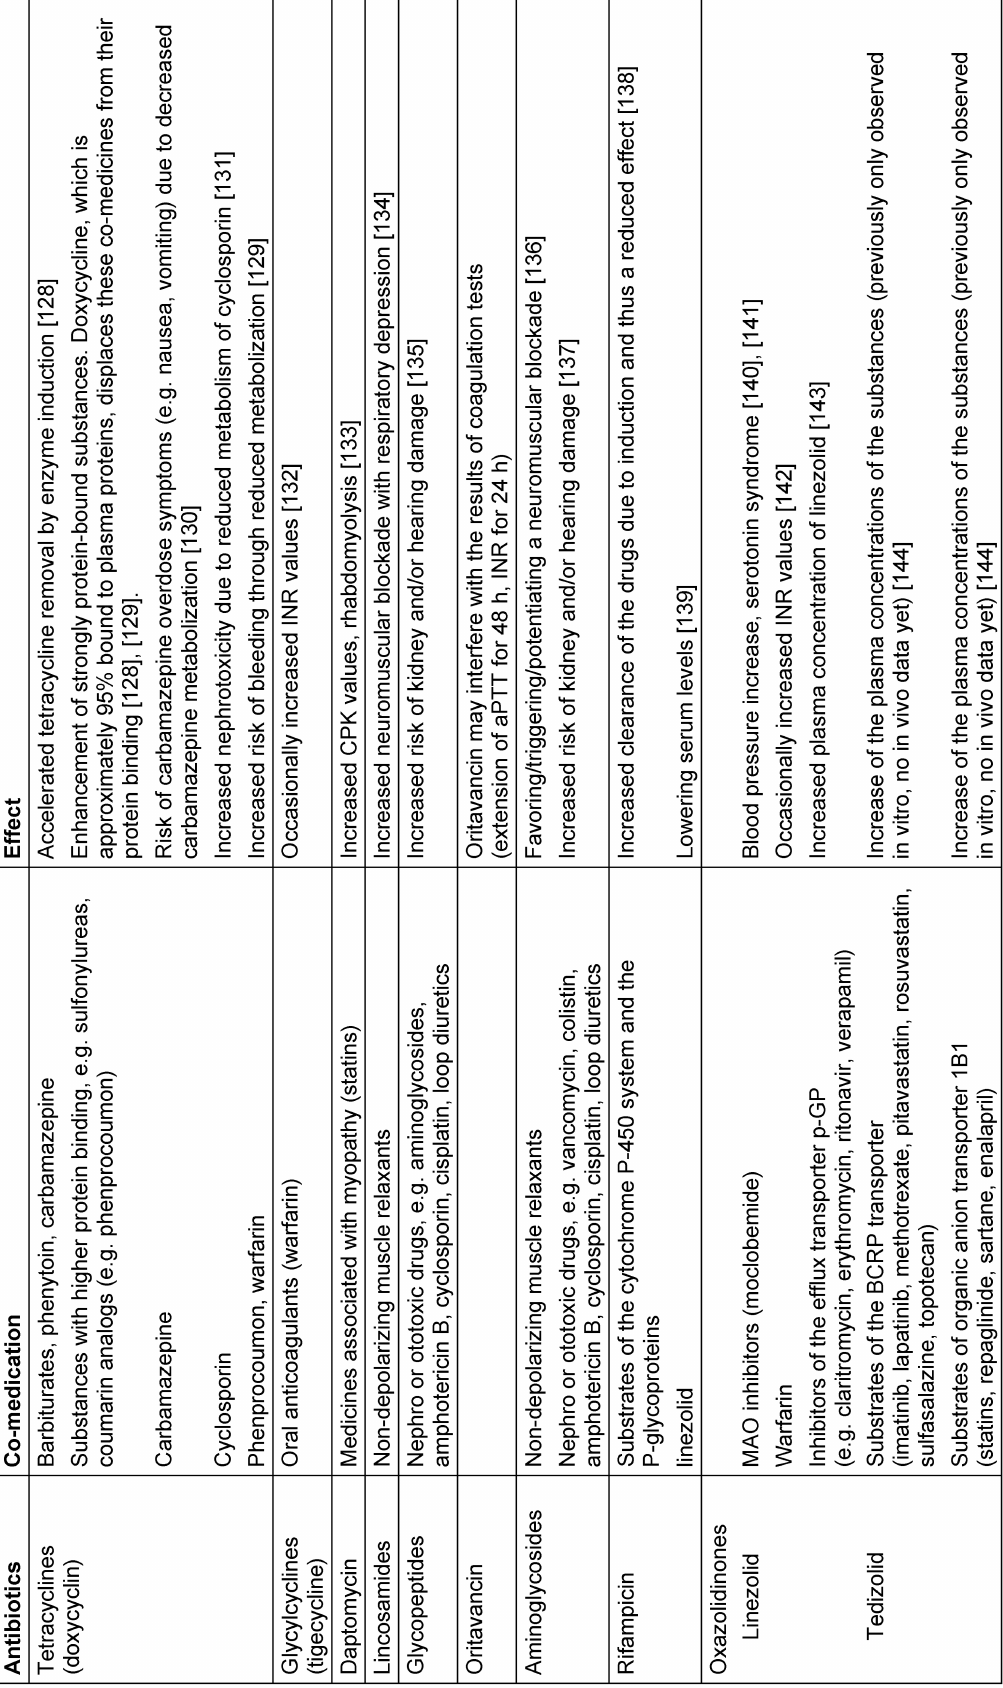
Table 6: Interactions of antibiotics with other medicines and their